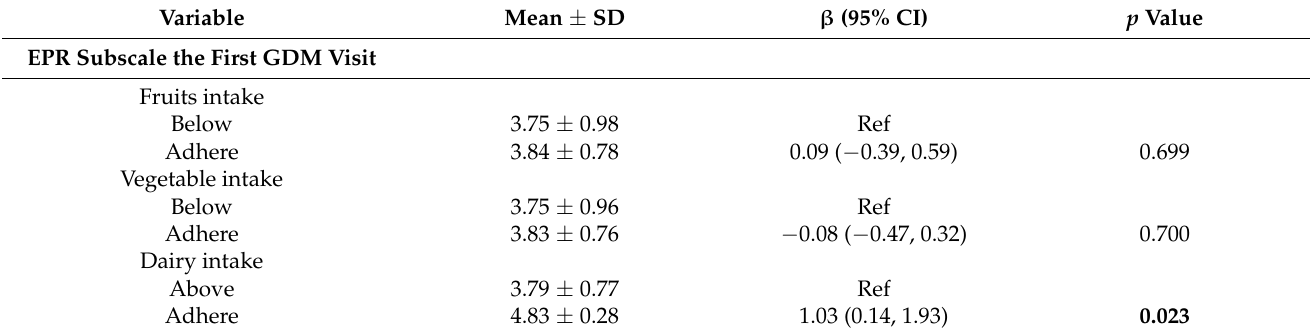
Table 5. Longitudinal relationship between intuitive eating subscales during pregnancy and adher- ence to Swiss society for nutrition recommendation at 1-year